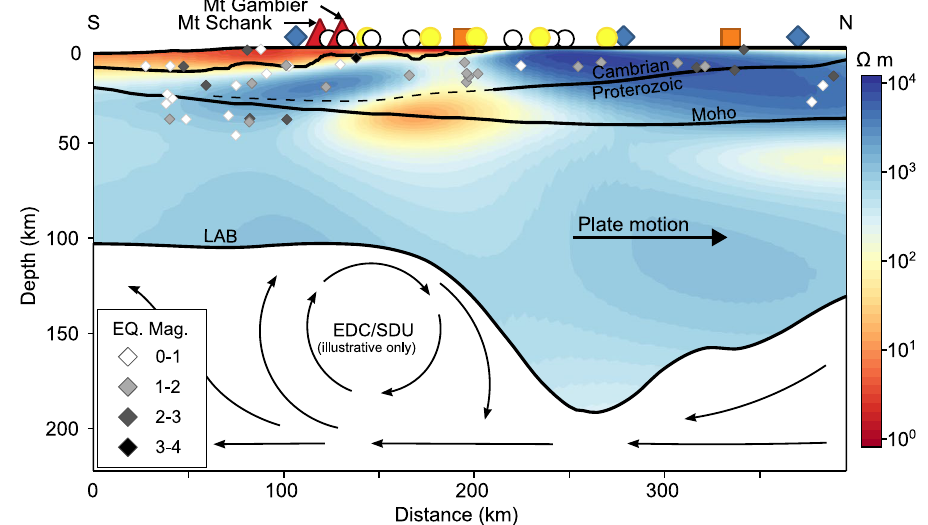
Figure 3. Profile A: N-S Resistivity cross-section passing close by Mt Gambier, Mt Schank, a resistivity low of ∼ 16 Ω m and a significant step in the seismically-defined lithosphere-asthenosphere boundary (LAB). Mantle flow vectors are not based on real data or modelling but are illustrative only. They serve to highlight relative mantle flow due to a northward moving Australian plate and the roughly anticipated position of a convection cell given the regional, seismically-defined LAB. The LAB 14 and Moho 36,37 surfaces are based on seismic modelling while the inferred Cambrian/Proterozoic interface 39,40 is determined through gravity modelling. Yellow circles—broadband MT sites as part of this paper, white circles—previously collected broadband MT, blue diamonds—AusLAMP and other long-period MT, orange squares—geomagnetic depth soundings. Our model is masked below the LAB due to a focus on crustal structures and low resolution at sub-crustal depths. See the Supplementary Materials for a discussion on model